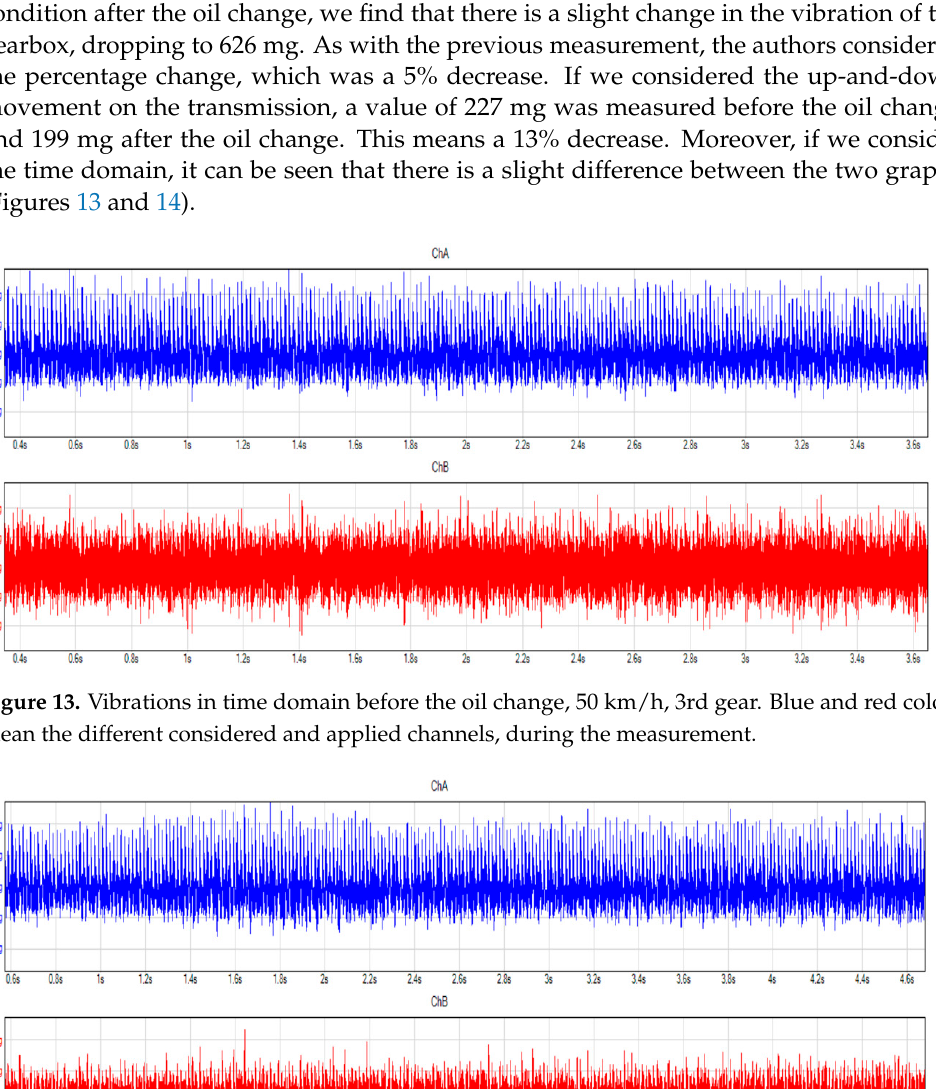
Figure 12. Vibrations in the frequency domain after the oil change, 0–70 km/h.